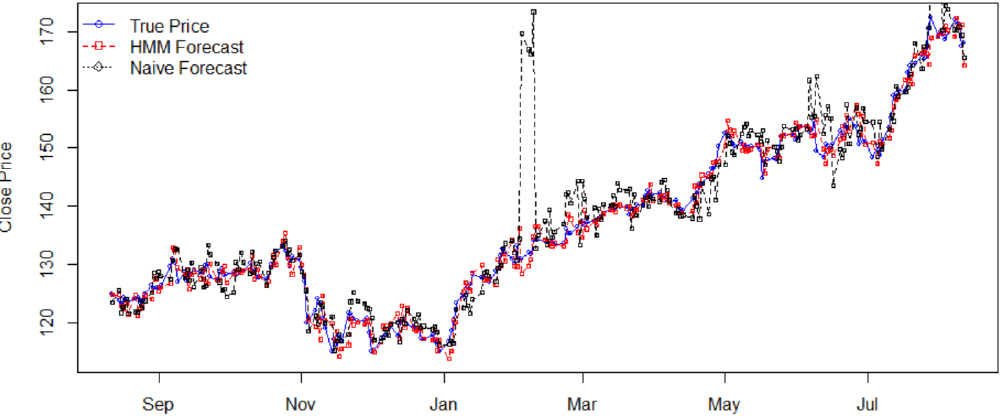
Figure 7. HMM prediction of Facebook stock daily close prices from 15 August 2016 to 11 August 2017 using two-states HMM and the naïve model.